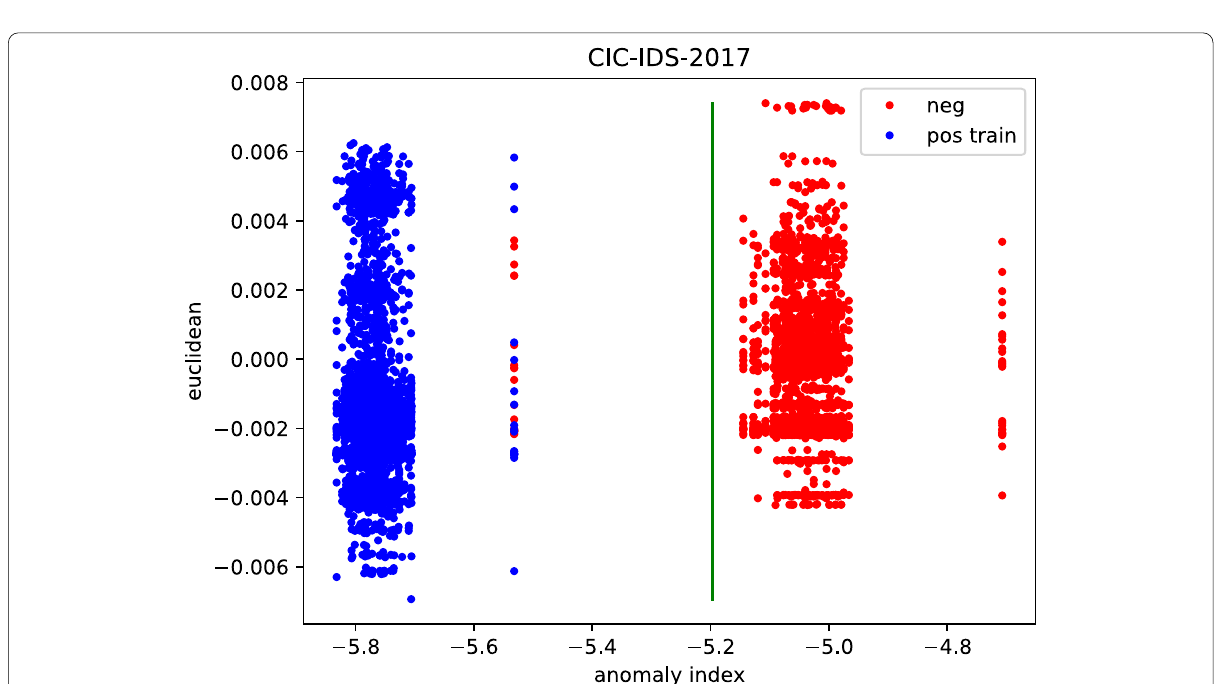
Fig. 12 Low-dimensional information of CIC-IDS-2017 sample after the model processing in this